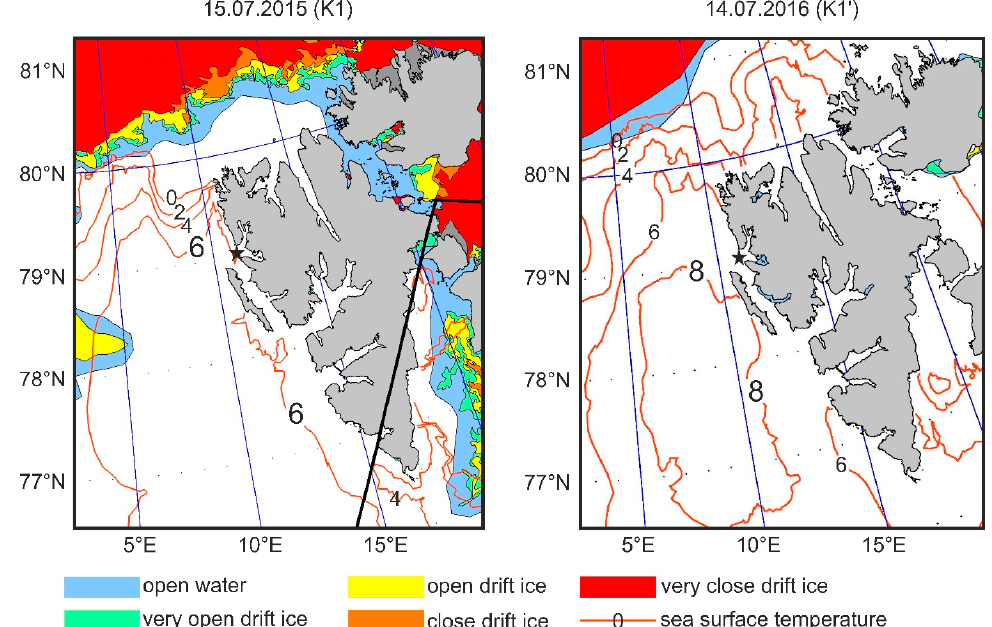
Figure 9. Sea surface temperature isoline and sea ice conditions (colour surfaces) in Svalbard waters in 2015 during K1 ( a ) and in 2016 during K1 ′ ( b ) study periods. Star icon represents Kongsfjorden study area. Data source: Norwegian Meteorological Institute.